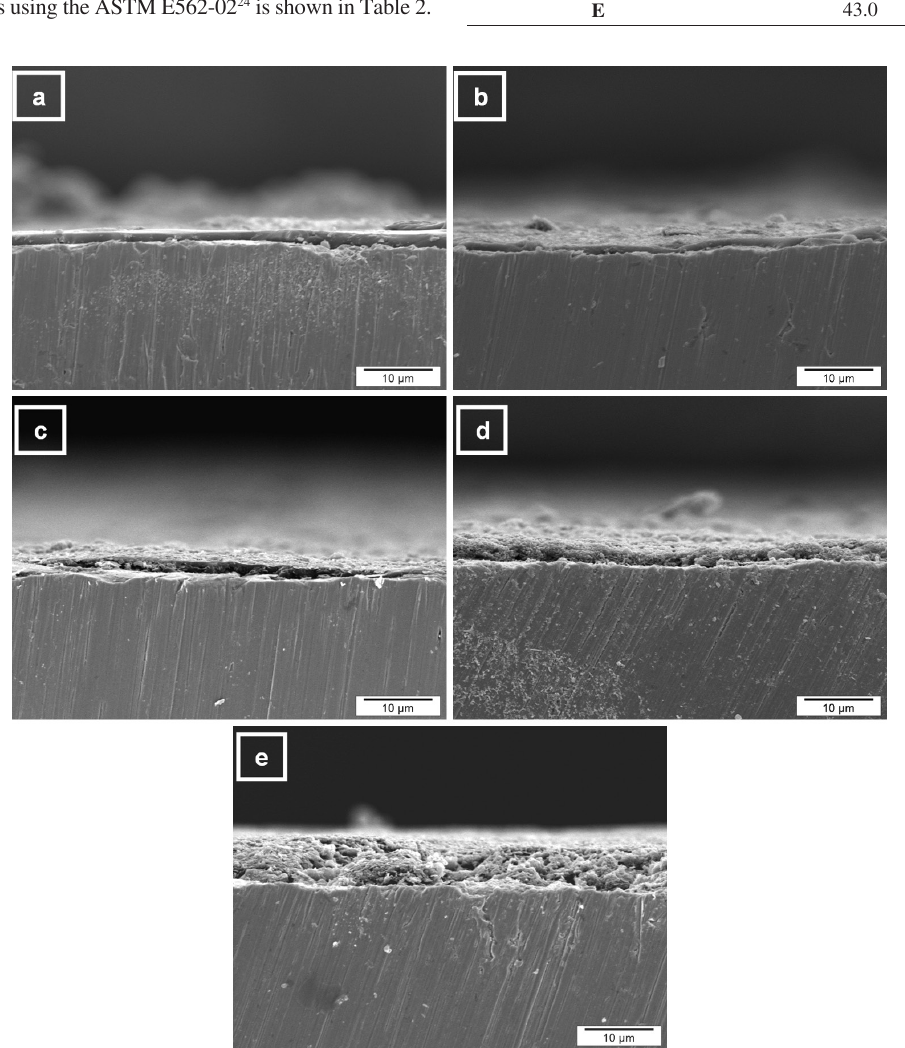
Figure 3. Micrographs of coatings from: (a) pure PMMA; (b) 90%PMMA-10%hBN; (c) 70%PMMA-30%hBN; (d) 50%PMMA-50%hBN; (e) 30%PMMA-70%hBN, on stainless steel.